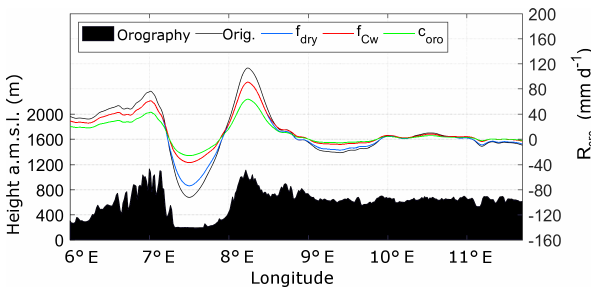
Figure 3. Different effects of the implemented internal free param- eters f dry (blue), f C (red), and c oro (green) on the original oro- w graphic precipitation part (black curve) for a west-to-east cross sec- tion through the model domain. The underlying orography is shown in